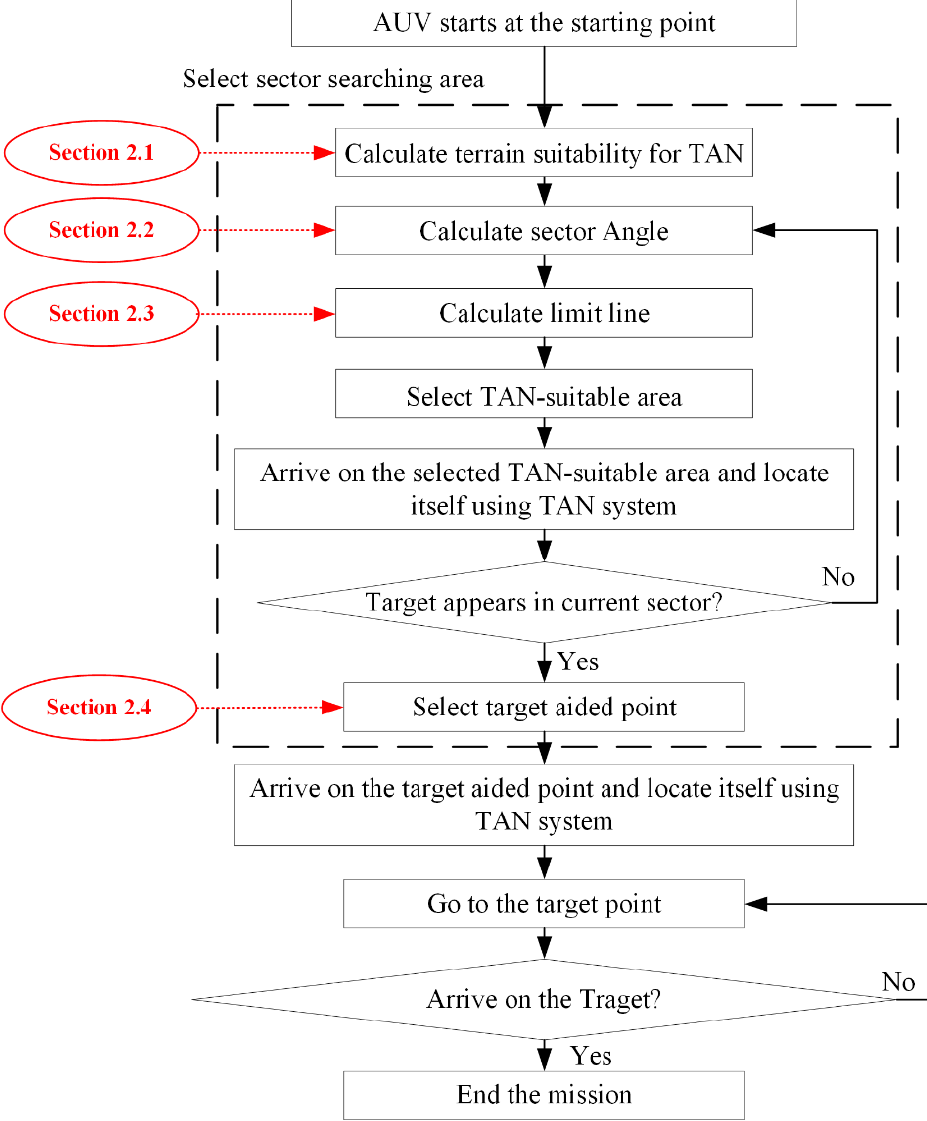
Figure 2. Flowchart of the proposed path planning algorithm. After determining the selection criterion of the TAN-suitable area, a sector searching method is proposed. As shown in Figure 3, the sector has a circle center of the current posi- tion of the vehicle (the starting point in Figure 3 at the initial time), and it is axisymmetric to the line between the current position of the AUV and the target